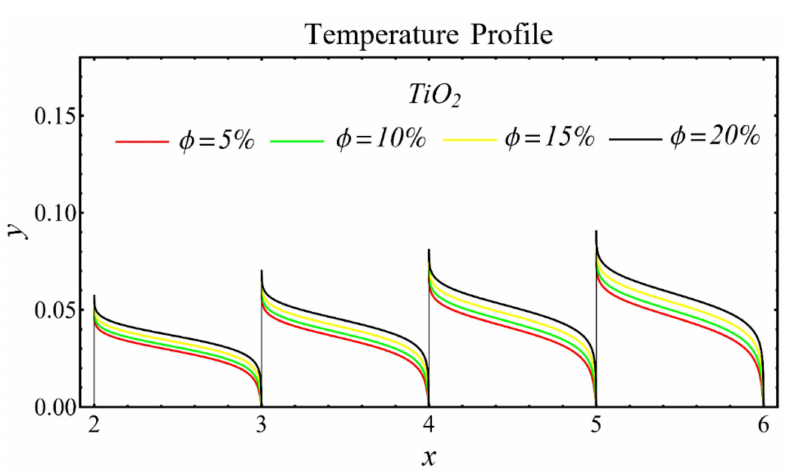
Figure 15. Temperature profile of TiO 2 -EG nanofluid under influence of nanoparticle